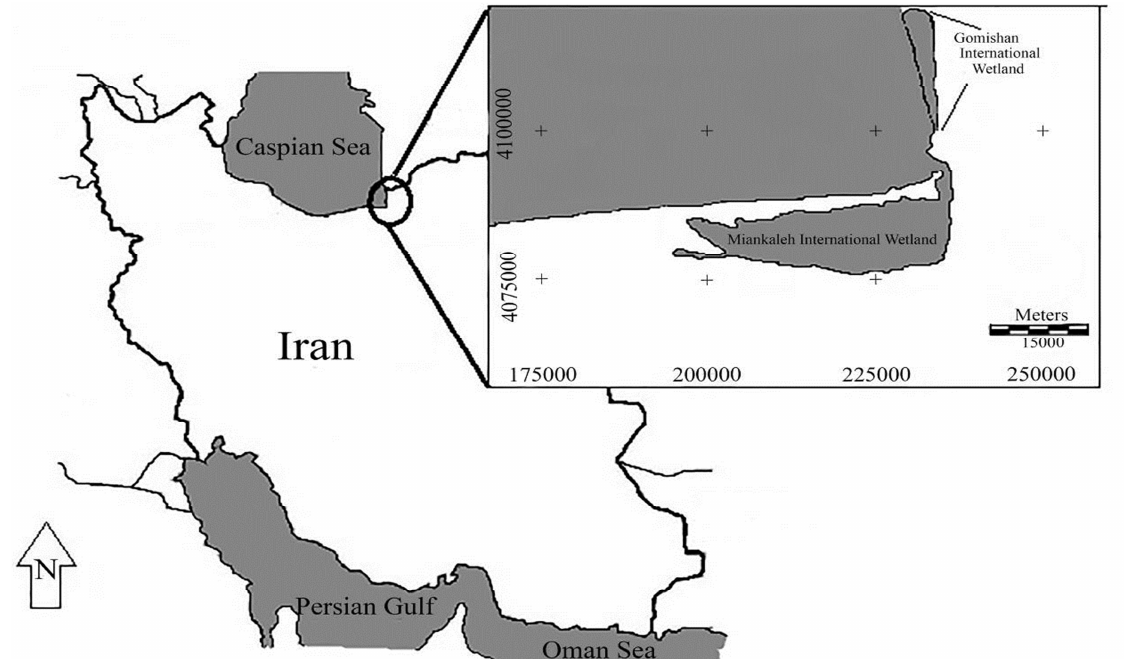
Figure 1. Sampling sites in the South East of the Caspian